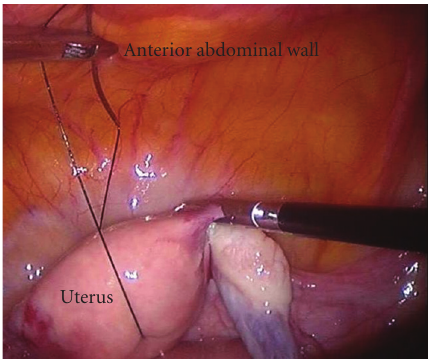
Figure 3: The uterus is suspended by two separate sutures through each of the round ligaments. This can be done in cases where the penetration of the uterus is against oncological principles, for example, in endometrial